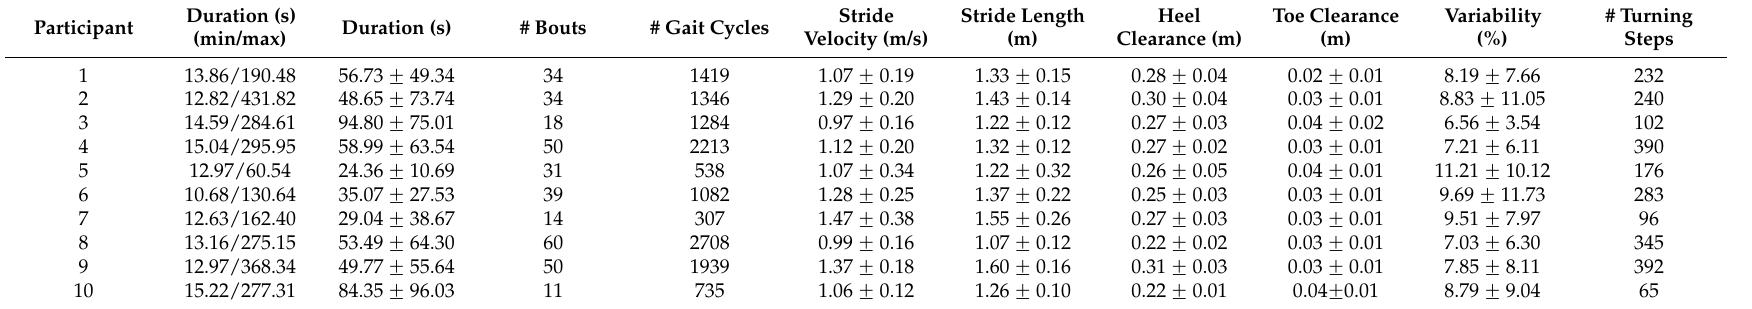
Table 3. Gait characterization from level walking periods of at least 20 steps. Reported values are mean ˘ SD unless otherwise stated.